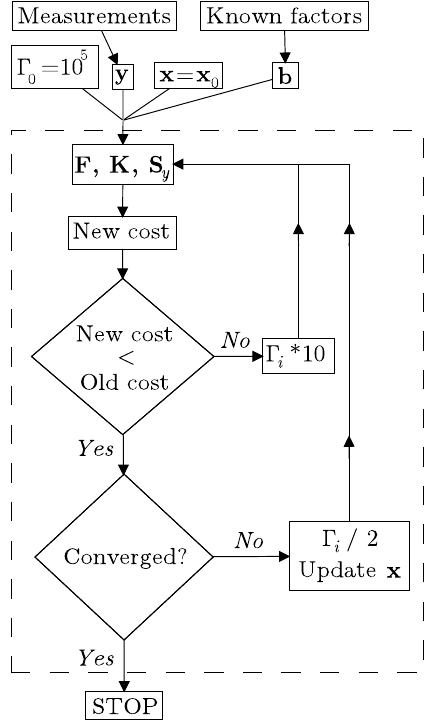
Fig. 1. Schematic of the optimal estimation retrieval algorithm.